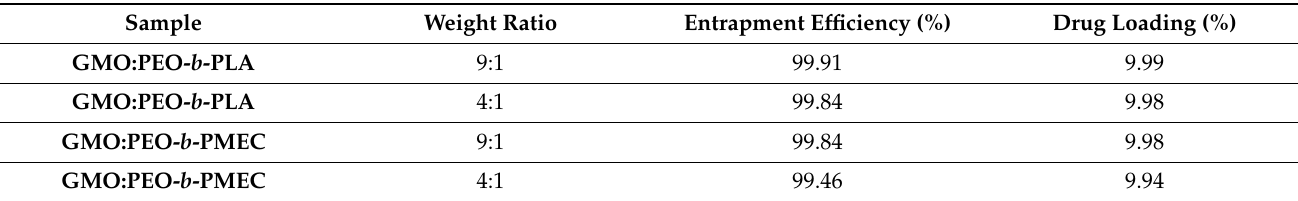
Table 3. Drug loading and entrapment efficiency